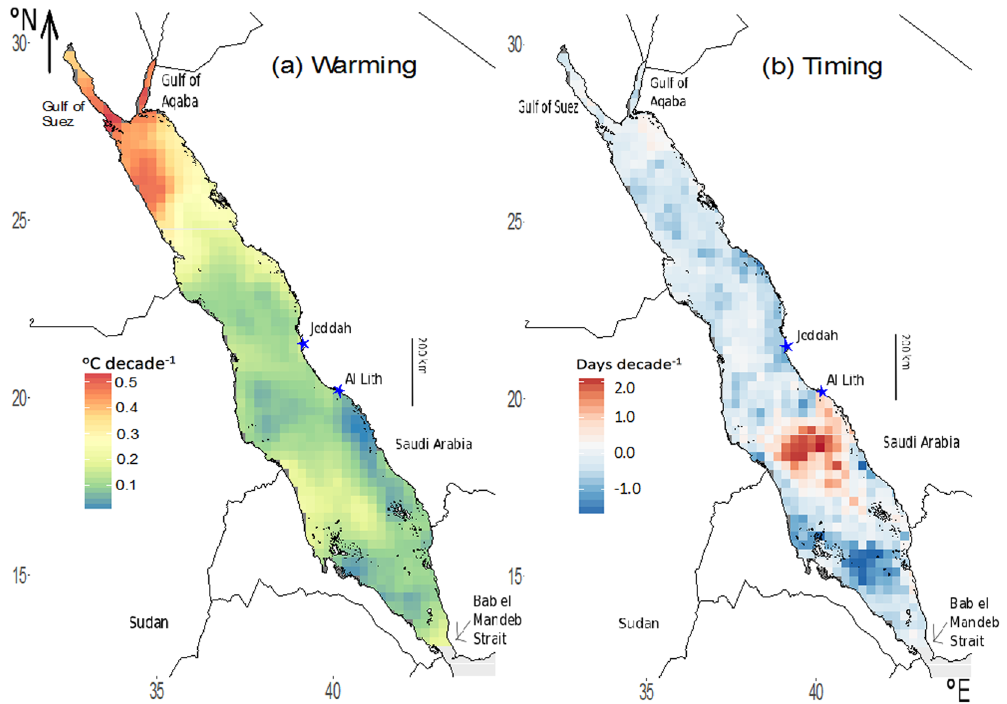
Figure 1. ( a ) Decadal rates of warming (°C decade − 1 ) and ( b ) change in timing (days decade − 1 ) of mean maximum annual temperature (T max ) across the Red Sea. Image created using R (v3.3.1, www.R-project.org) 45 including packages: ggplot2 46 and rasterVis 47 , RStudio (v1.0.143, www.rstudio.com), and InkScape (v0.91, www.